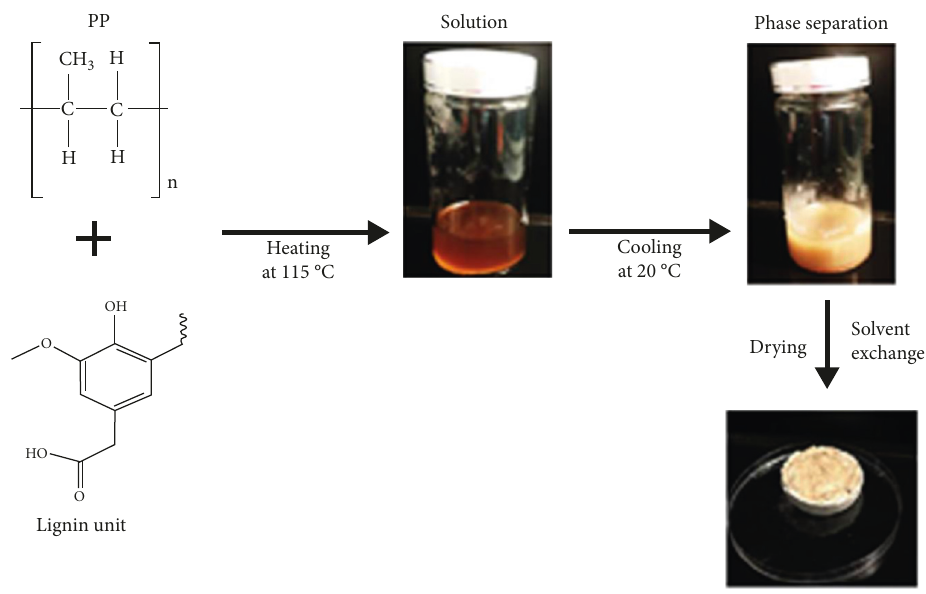
Figure 2: A general protocol for using a thermally induced phase separation technique to prepare PP/lignin blend monoliths [99] (Copyright @ 2020 Elsevier under CC BY-NC-ND